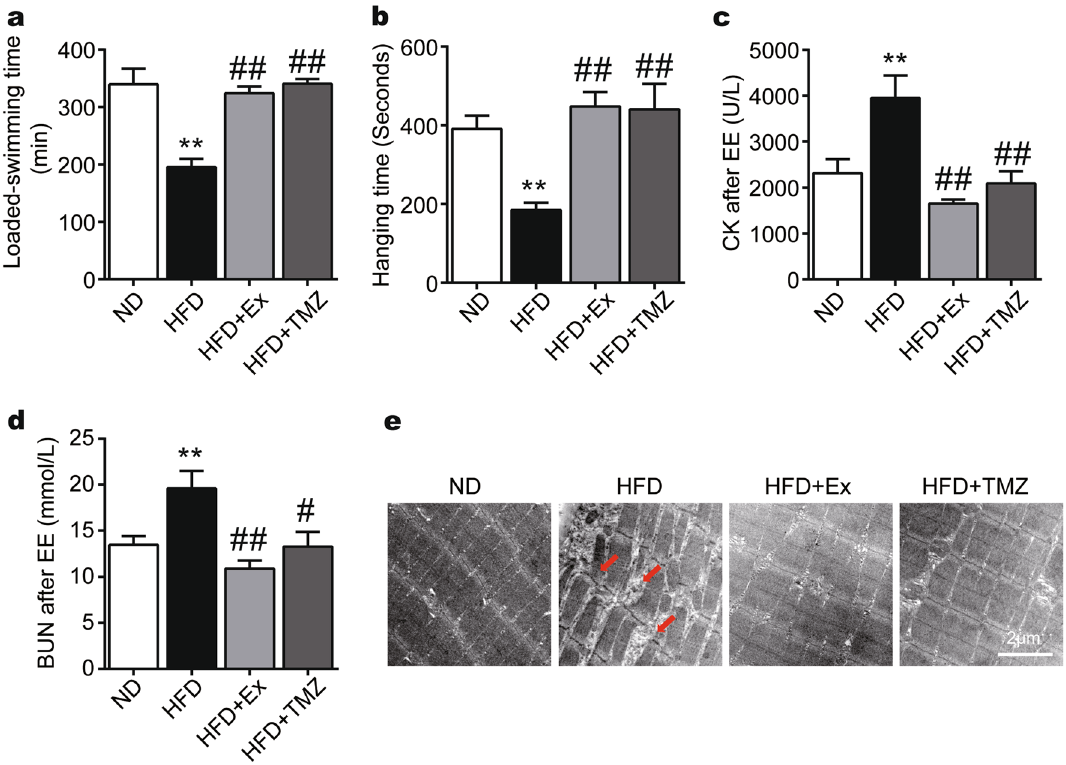
Figure 5. TMZ regulates muscle function in the HFD mice comparably to exercise. ( a ) The forced weight- loaded swimming time was recorded as exercise capacity ( EE exhaustive exercise). ( b ) The limb strength of the skeletal muscles was tested by the inverted screen test, meanwhile the fall-off time was recorded. ( c , d ) Plasma creatine kinase (CK) concentrations and plasma urea nitrogen (BUN) were observed after EE. ( e ) The skeletal structures of HFD mice were observed by transmission electron micrograph after EE with a scale of 2 μm. The red arrow represented the disordered and ruptured arrangement of the skeletal muscle fibers. *, ** represented p < 0.05, p < 0.01 in comparison with ND group, respectively; # , ## represented p < 0.05, p < 0.01 in comparison with HFD group,